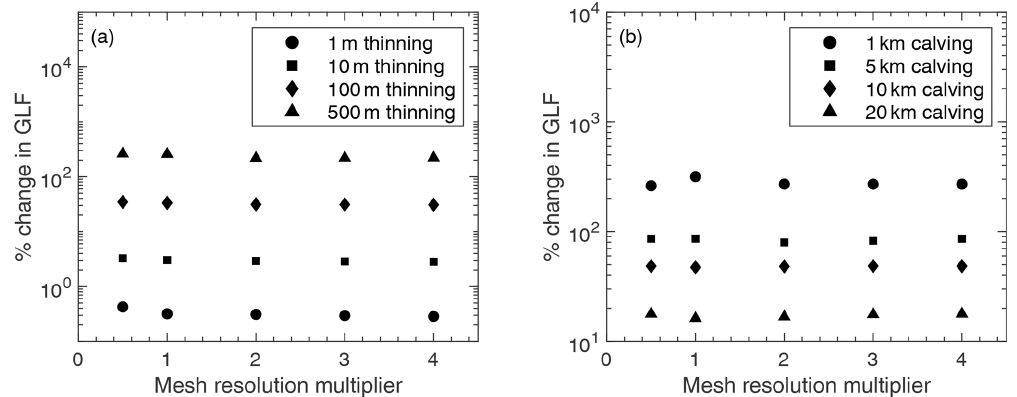
Figure C1. Mesh convergence analysis: here, the percentage change in grounding line flux for five of the uniform thinning experiments (a) and five of the idealised calving experiments (b) is plotted for meshes in which the element sizes were half, double, triple and quadruple the size of the original mesh used for analysis in the main text.